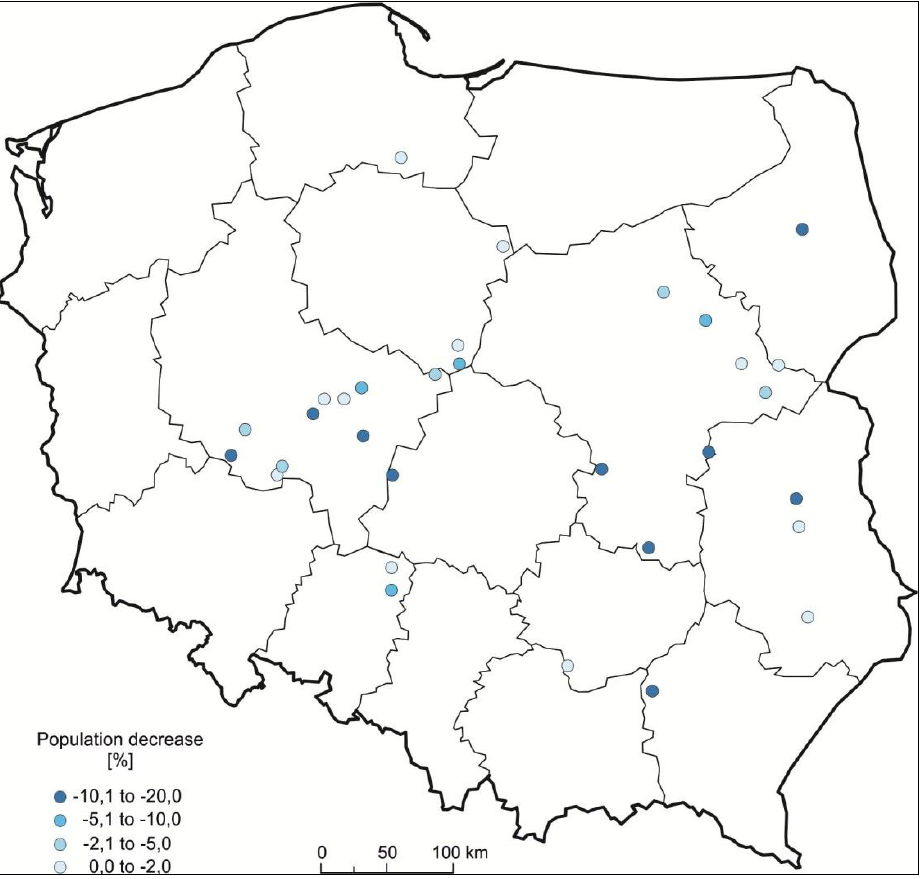
Fig. 2. Population decrease in towns of Poland, 1950-1960 (by author on the basis of Annex 2: Kantor-Pietraga, 2014) The area of the contemporary Greater Poland province constituted an interesting